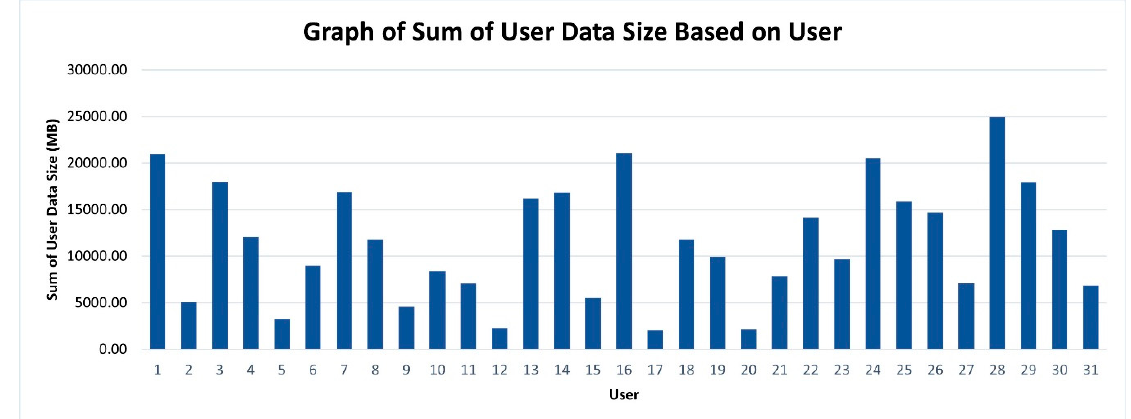
Figure 7. Graph of the sum of user data size vs. users.